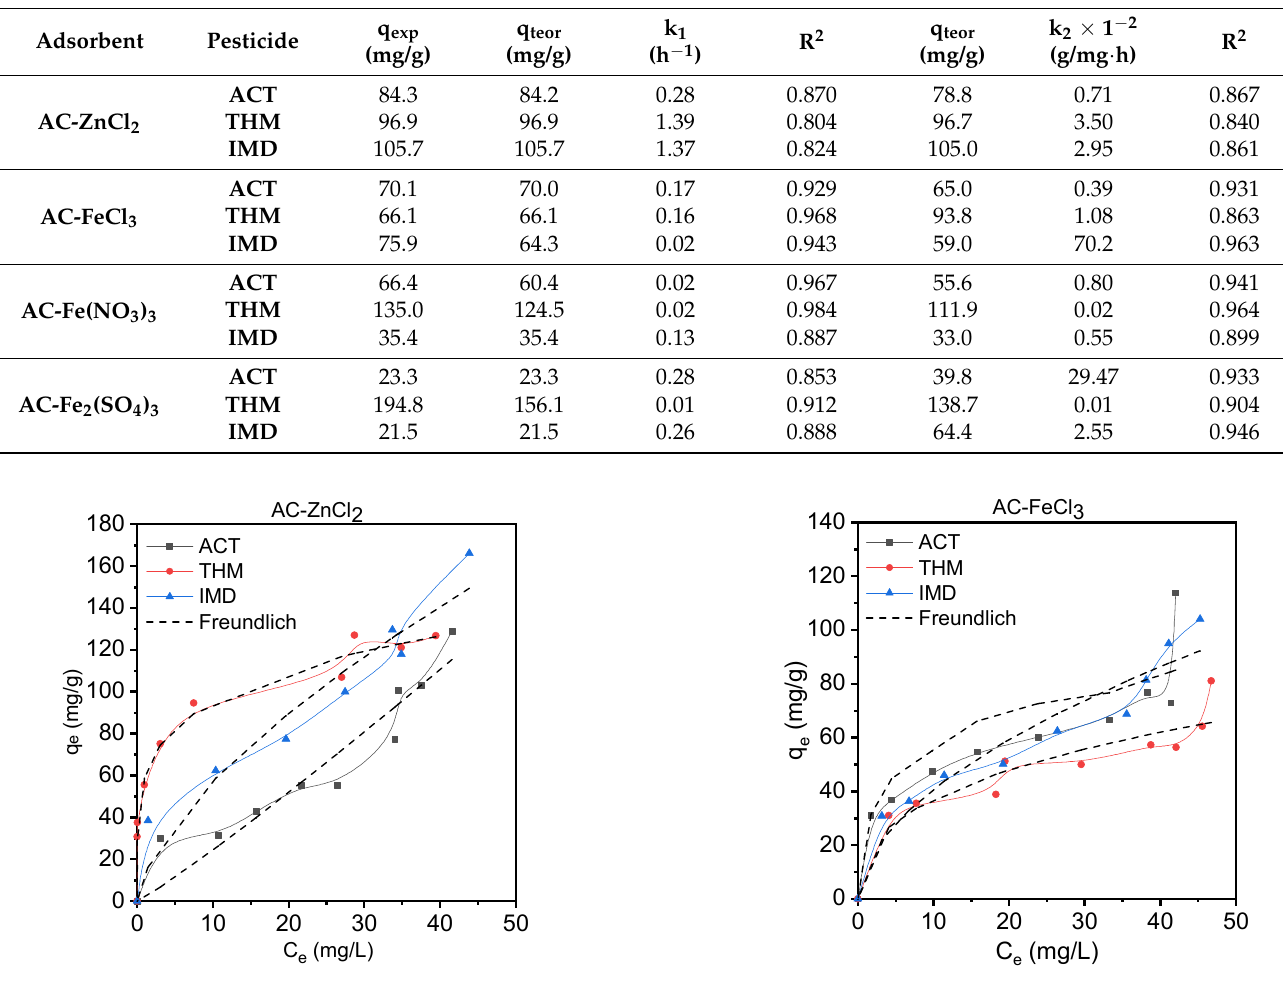
Table 4. Kinetic model parameters for the adsorption of ACT, THM, and IMD onto the carbon materials. Pseudo-First-Order Model